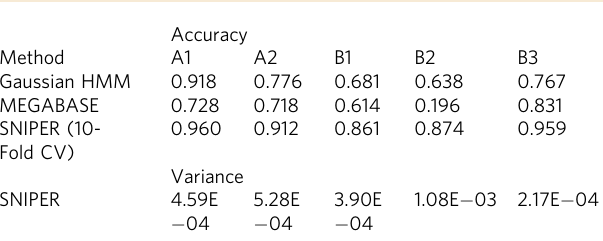
different inter-chromosomal read pairs as compared to the full coverage inter-chromosomal contact map where there are 740 million read pairs between the odd-numbered and the even- numbered chromosomes. In Table 2, we show the percentage of NATURE COMMUNICATIONS| (2019) 10:5069